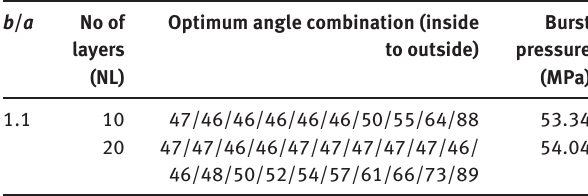
Table 3: Optimum ply angles and the maximum burst pressure obtained using the BB-BC